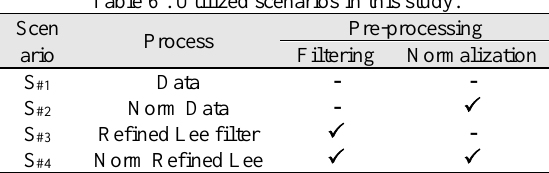
Table 6 . Utilized scenarios in this